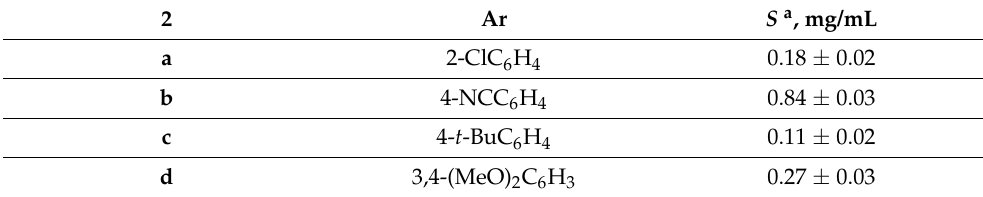
Table 1. Intrinsic solubilities (S) of SCOs 2 . 2 Ar S a , mg/mL